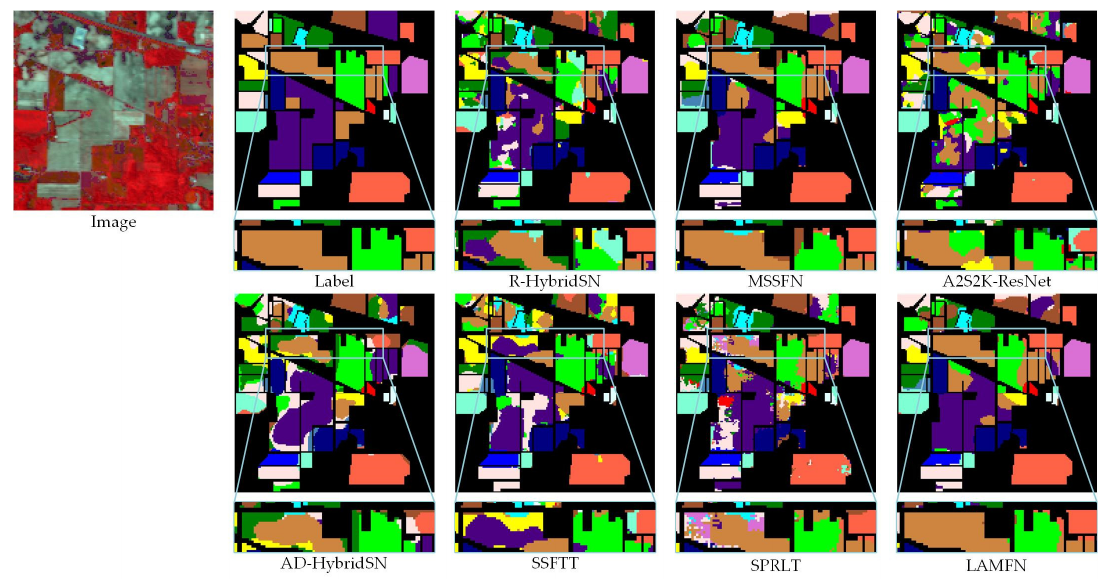
Figure 5. Classification maps of all models for IP dataset.